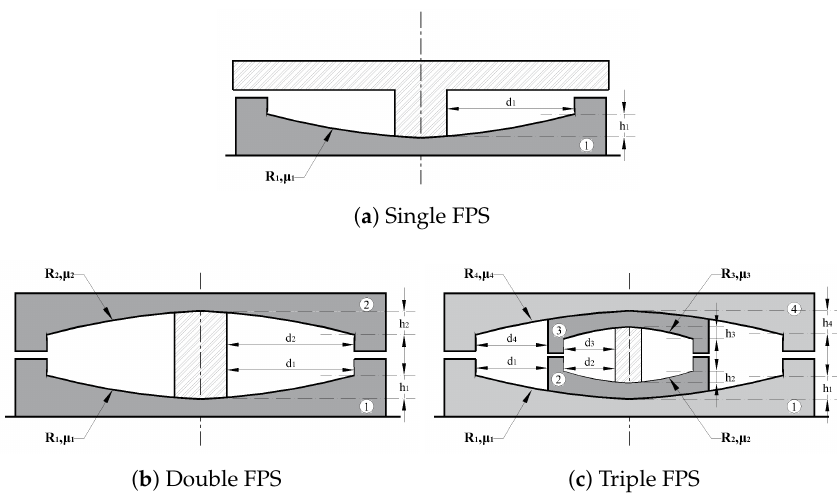
Figure 1. Variations of friction pendulum systems, R is the concave plate radius and µ is the dynamic friction